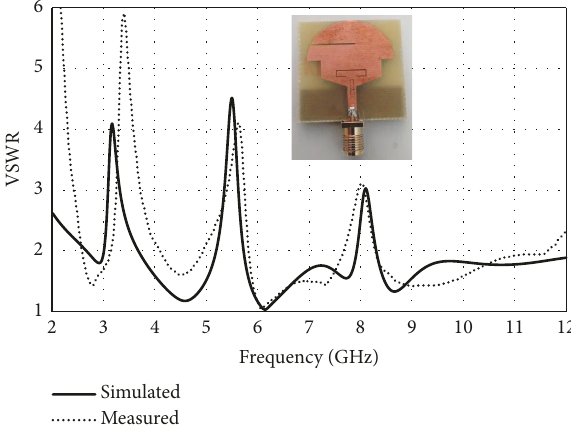
Figure 14: Measured and simulated VSWR of the proposed UWB